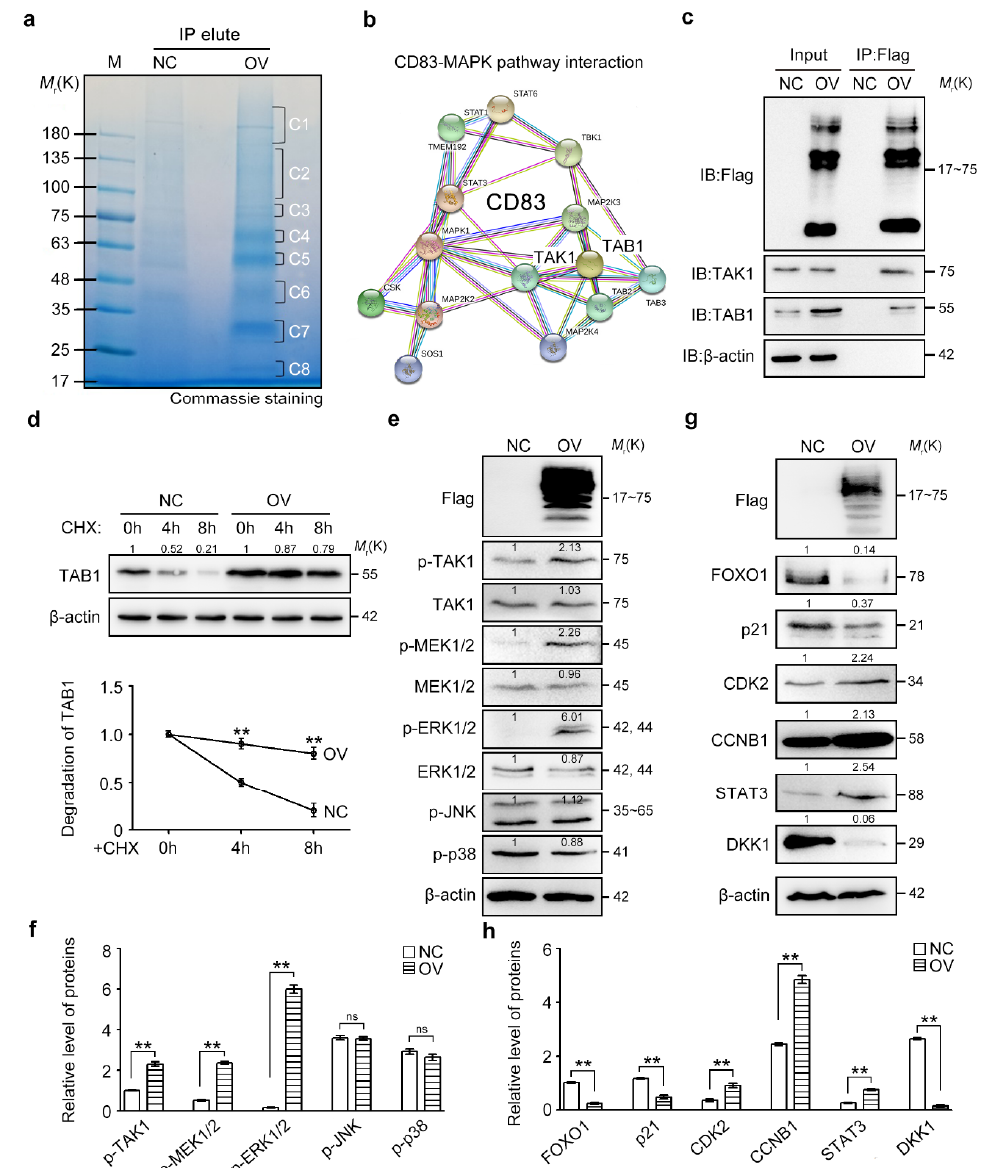
Figure 5. Transmembrane CD83 interacted with TAK1 and TAB1 and activated MAPK and downstream signaling pathways. ( a ) CD83 C-terminal 3 × Flag lentiviral plasmid and the stable cell lines